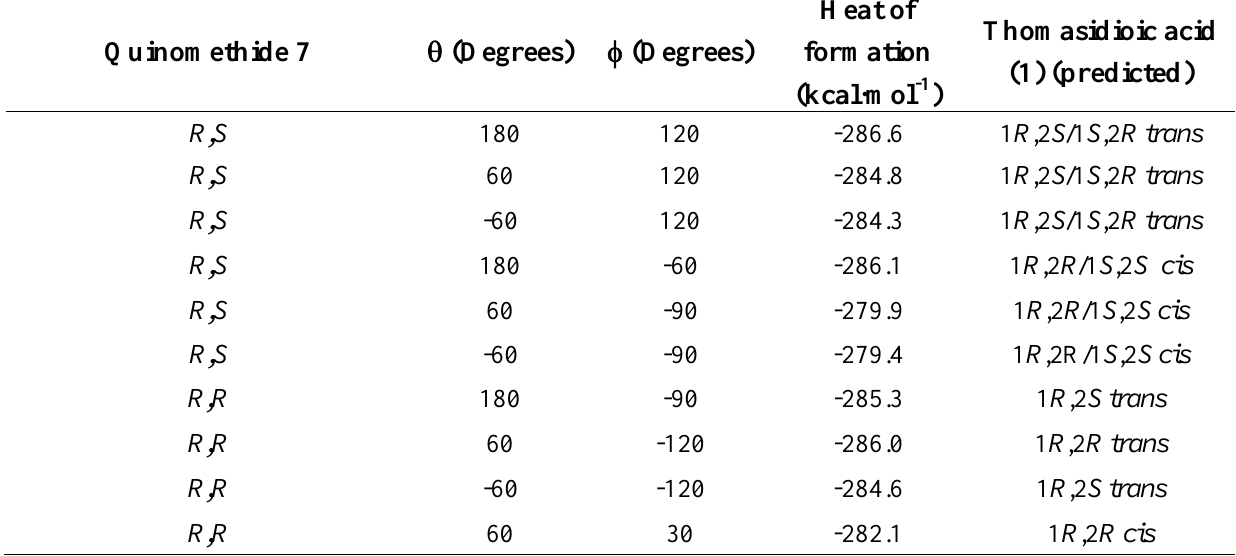
Table 3 . Energy minima on the PES of the quinomethides 7 calculated as a function of the θ and φ dihedral angles (see Scheme 3) at the semiempirical PM3 level of